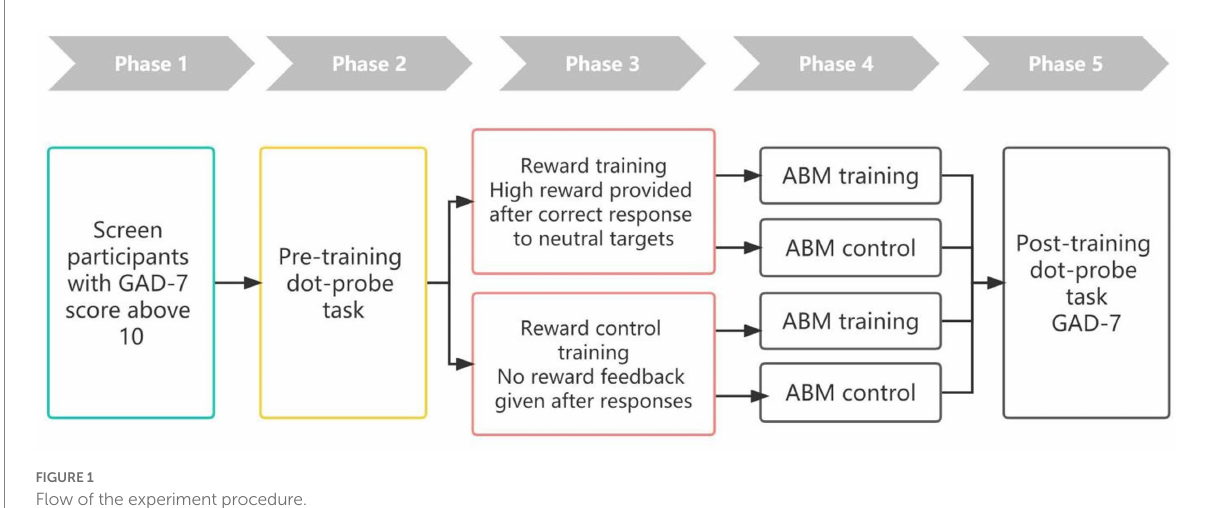
FIGURE 1 Flow of the experiment procedure.